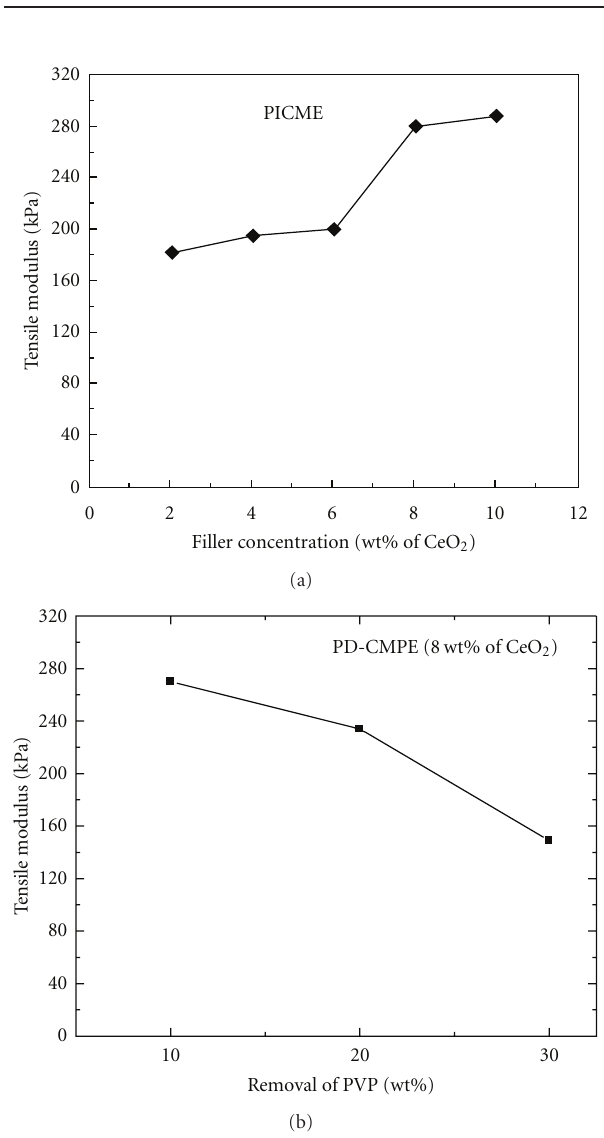
Figure 3: Mechanical strength of (a) PICME (b) PDCME.